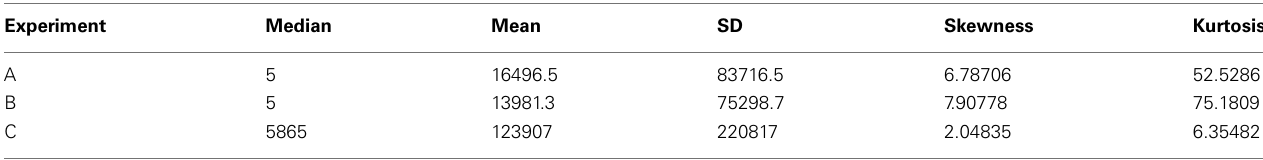
TableA1 | Data for the max sizes of masses that eventually die out.